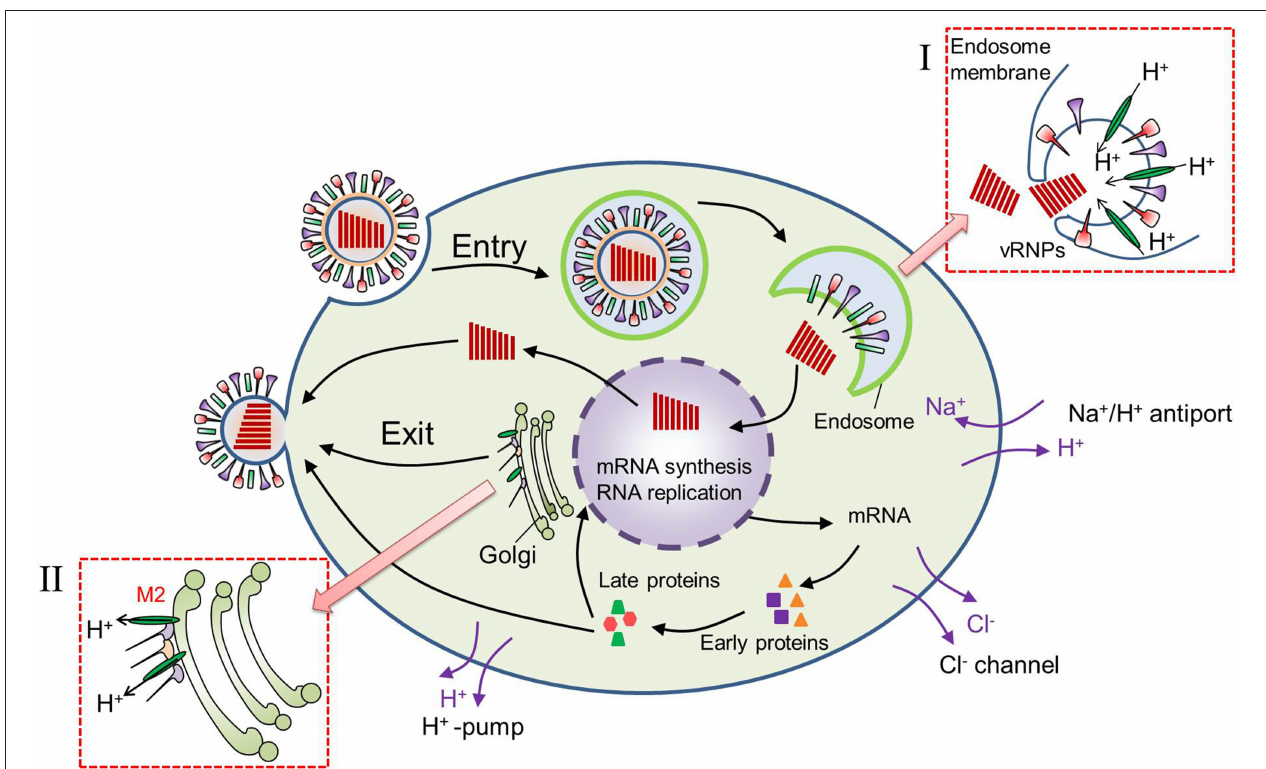
FIGURE 7 | Virus replication cycle after virus infection into a cell. (I) During virus entry, M2 proton channel shunts H + from the acidic endosome to the virion interior, leading to membrane fusion and release of the genome. (II) During virus exit, M2 shunts H + from trans-Golgi network to the cytoplasm, preventing premature conformational changes in the viral hemagglutinin